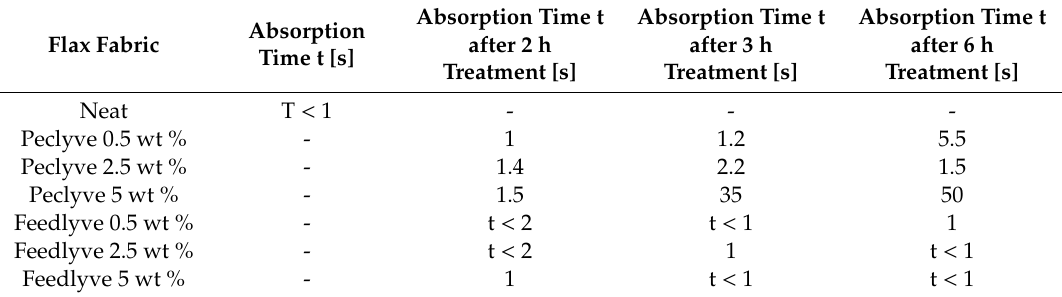
Table 2. Water absorption time values obtained for the untreated and enzymatically treated flax fabric surface.